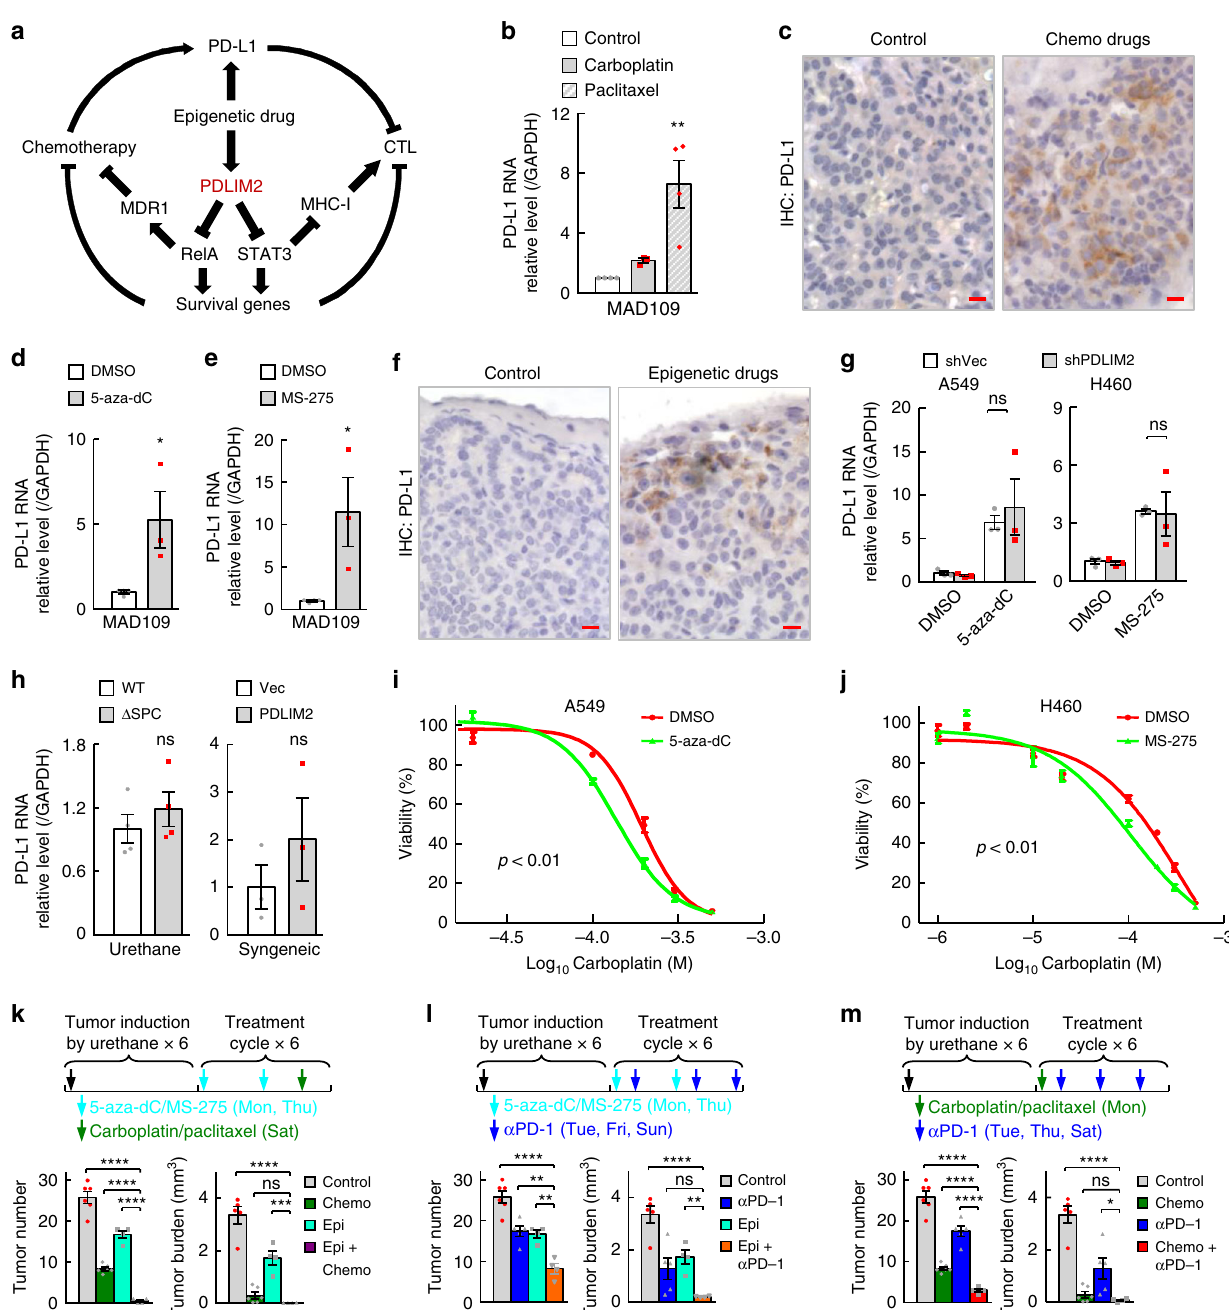
Fig. 7 Epigenetic agents, chemotherapeutic drugs and anti-PD-1 synergize in lung cancer treatment. a Mechanistic rationale for combination therapy using anti-PD-1, chemotherapeutic drugs and epigenetic agents. b qPCR showing PD-L1 induction in lung cancer cells by carboplatin and paclitaxel ( n ≥ 3). c IHC showing PD-L1 induction in lung tumors by chemotherapy in urethane model. Scale bar, 10 μ m. d , e qPCR showing PD-L1 induction in lung cancer cells by 5- aza-dC or MS-275 ( n ≥ 3). f IHC showing PD-L1 induction in lung tumors by epigenetic therapy in urethane model. Scale bar, 10 μ m. g qPCR showing no signi fi cant effect of PDLIM2 knockdown on PD-L1 induction in lung cancer cells by epigenetic drugs ( n = 3). h qPCR showing no signi fi cant effect on PD-L1 expression in lung tumors by PDLIM2 deletion (urethane model, n = 4) or by PDLIM2 reconstitution (MAD109 syngeneic mouse model, n = 3). i , j In vitro IC 50 assay showing increased carboplatin sensitivity by 5-aza-dC in A549 cells and by MS-275 in H460 cells ( n = 3). k Urethane model showing complete remission of almost all lung cancers by epigenetic and chemo combination therapy ( n ≥ 4). l , m Urethane model showing better lung cancer treatment with epigenetic and anti-PD-1 combination therapy or chemo- and anti-PD-1 combination therapy ( n ≥ 4). Student ’ s t test (two tailed, unpaired) was performed, and data represent means ± SEM in ( b , d , e , g – m ). * P < 0.05; ** P < 0.01; *** P < 0.001; **** P < 0.0001; ns, not statistically signi fi